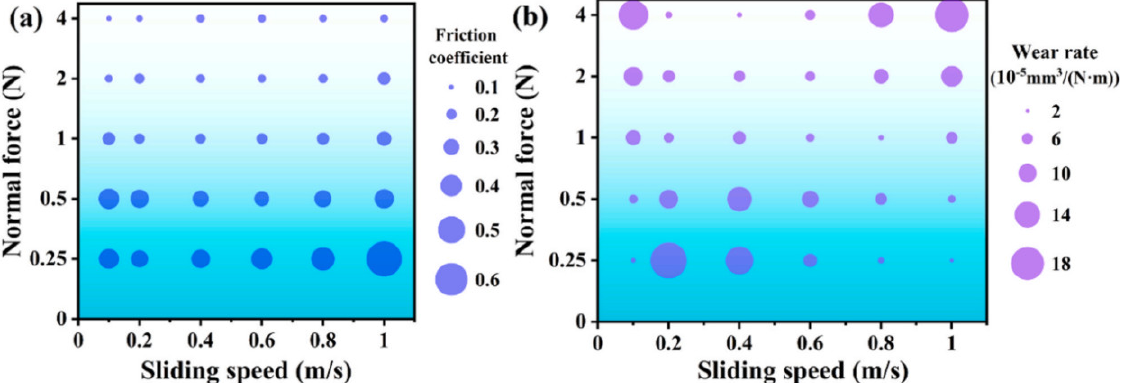
Figure 11. The friction coefficient ( a ) and wear rate ( b ) of the Ag/MoS 2 /WS 2 nanocomposites under different normal forces and sliding speeds [87].